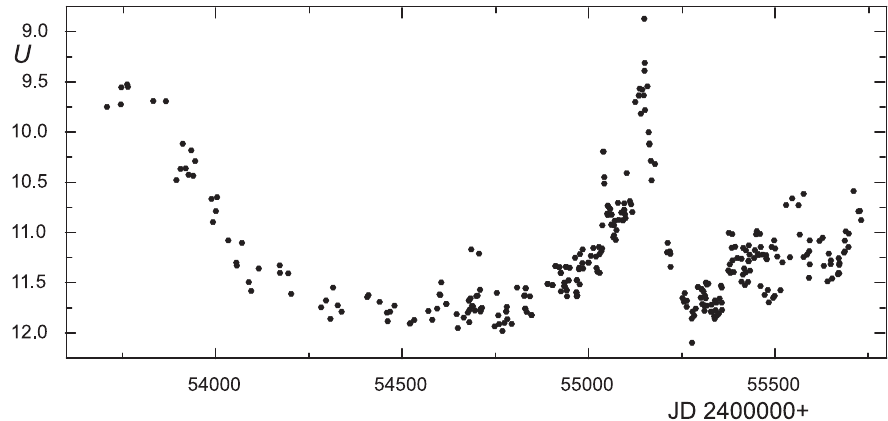
Fig. 1. U light curve of CH Cyg from 2006 to present.